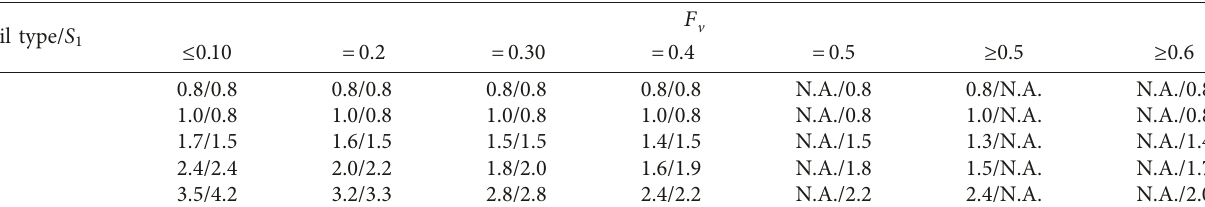
Table 10: Site effects (the USA) in the long period range [12, 22].